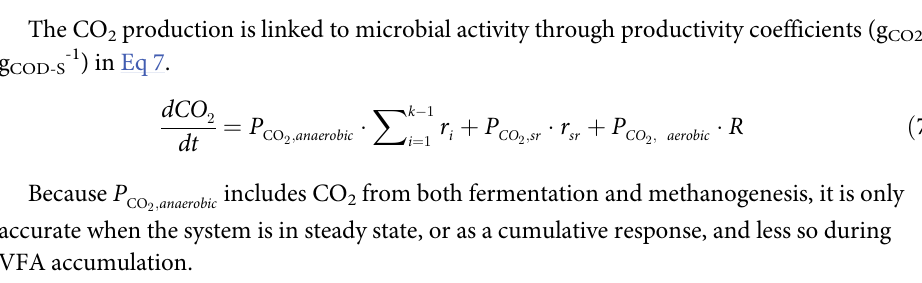
) in the fresh slurry. kg (cid:0) 1 COD (cid:0) B slurry ð g ), so CH production rate ( g g (cid:0) 1 d (cid:0) 1 ) is given by Eq 6. 4 CH 4 COD (cid:0) S CH 4 CH 4 dCH 4